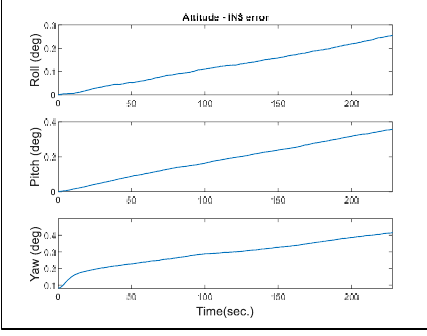
Figure 23. Attitude error in INS